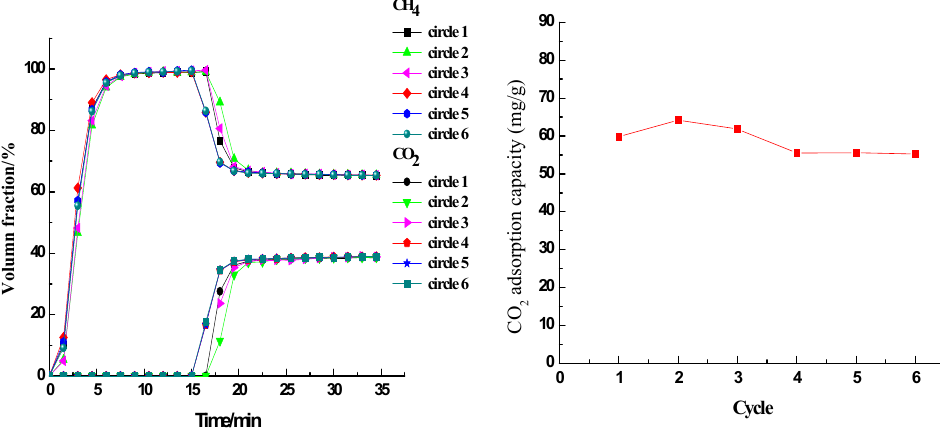
Figure 9. Adsorption/desorption cycles for FS-15%PEI-5%MEA.